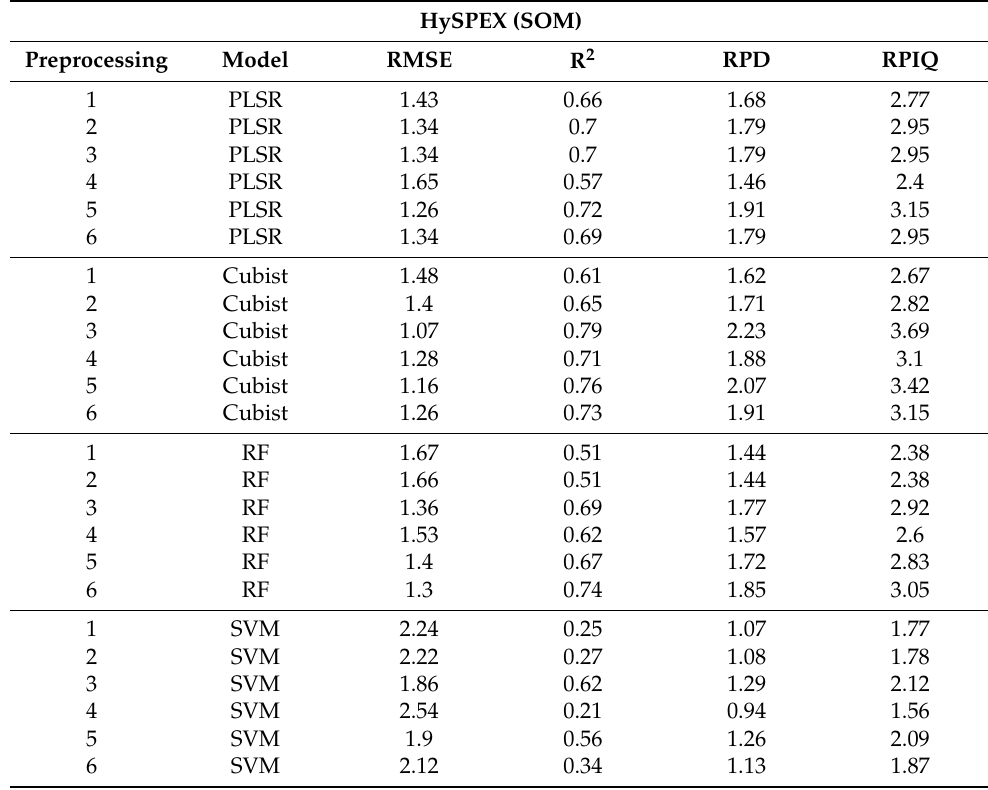
Table A2. Statistical evaluation of the models used to predict the soil organic matter (SOM) content from the HySpex